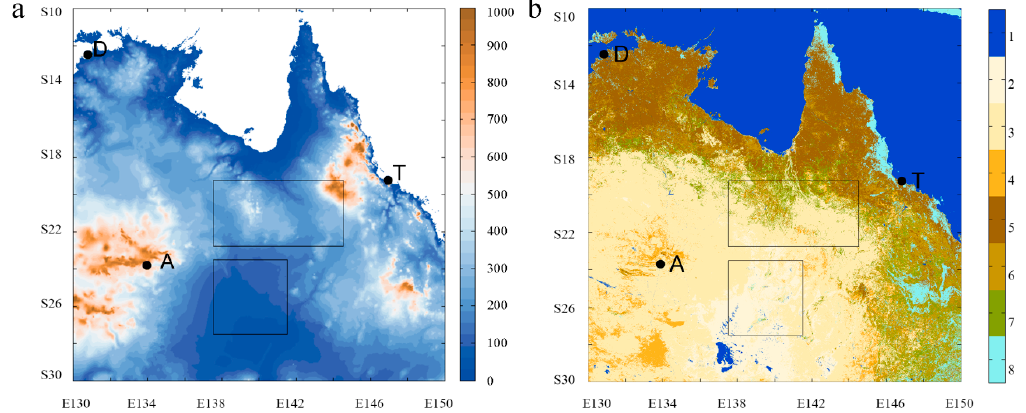
Figure 1. Topography ( a ) and land cover ( b ) over northeastern Australia (S10°–S30°; E130°–E150°). Letters D, T, and A indicate the cities of Darwin, Townsville, and Alice Springs, respectively, which are identical in the following figures. The selected rectangular sub-region (REC, (S19.25°–S22.75°; E137.5°–E144.5°) covering about 28,340 km 2 ) and square sub-region (SQU, (S23.5°–S27.5°; E137.5°–E141.5°) being about 17,892 km 2 ) are illustrated. In ( a ) the DEM of GTOPO30 data is used, and statistical characteristics of elevation in REC and SQU sub-regions, including minimum, maximum, mean, and standard deviation, are (87, 1136, 273, 126) and (44, 202, 87, 25) meters above mean sea-level, respectively. In ( b ) land cover is based on GlobCover2009 data from European Space Agency GlobCover Portal. More detail of the legend is listed in Table 1.